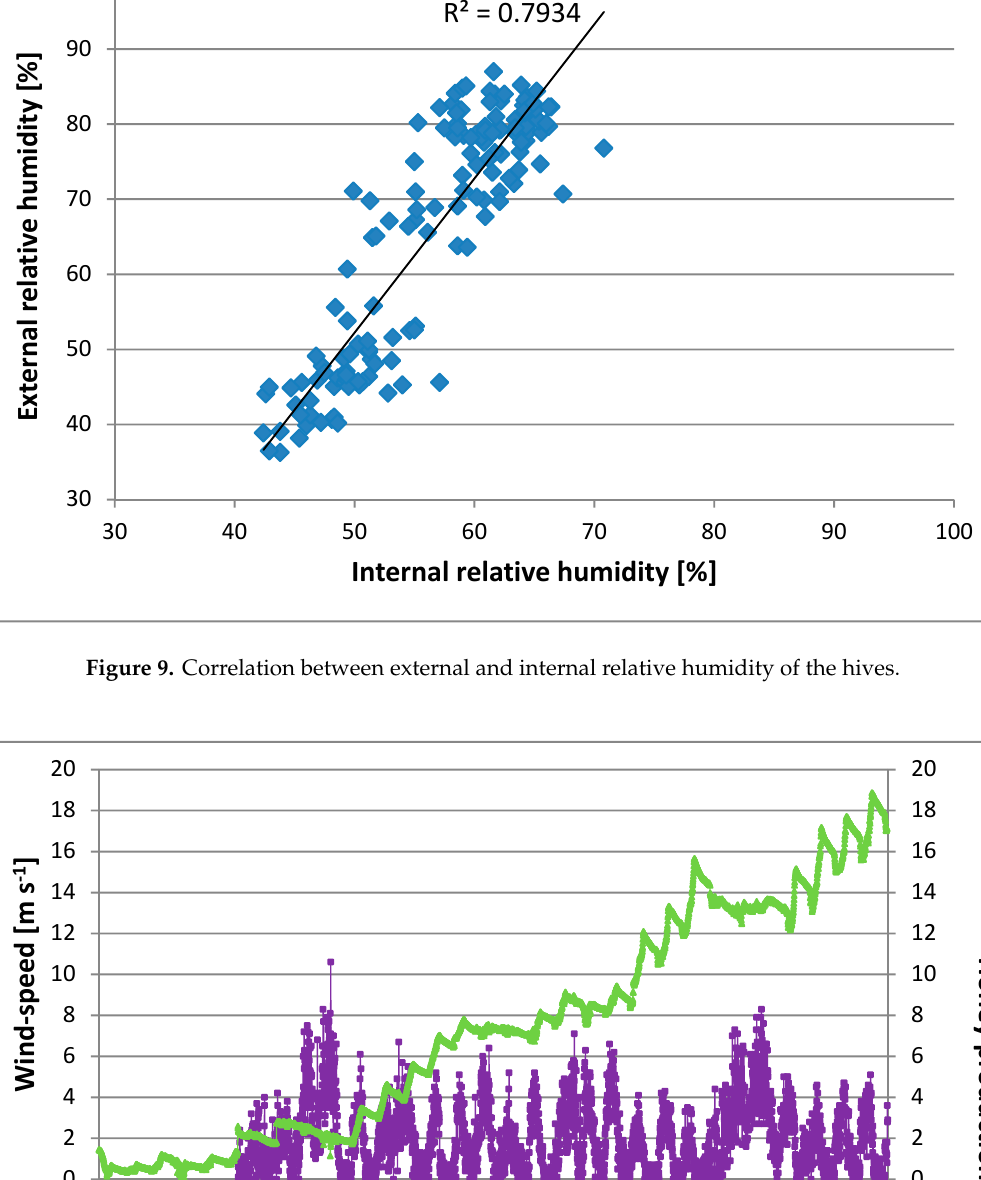
Figure 9. Correlation between external and internal relative humidity of the hives.